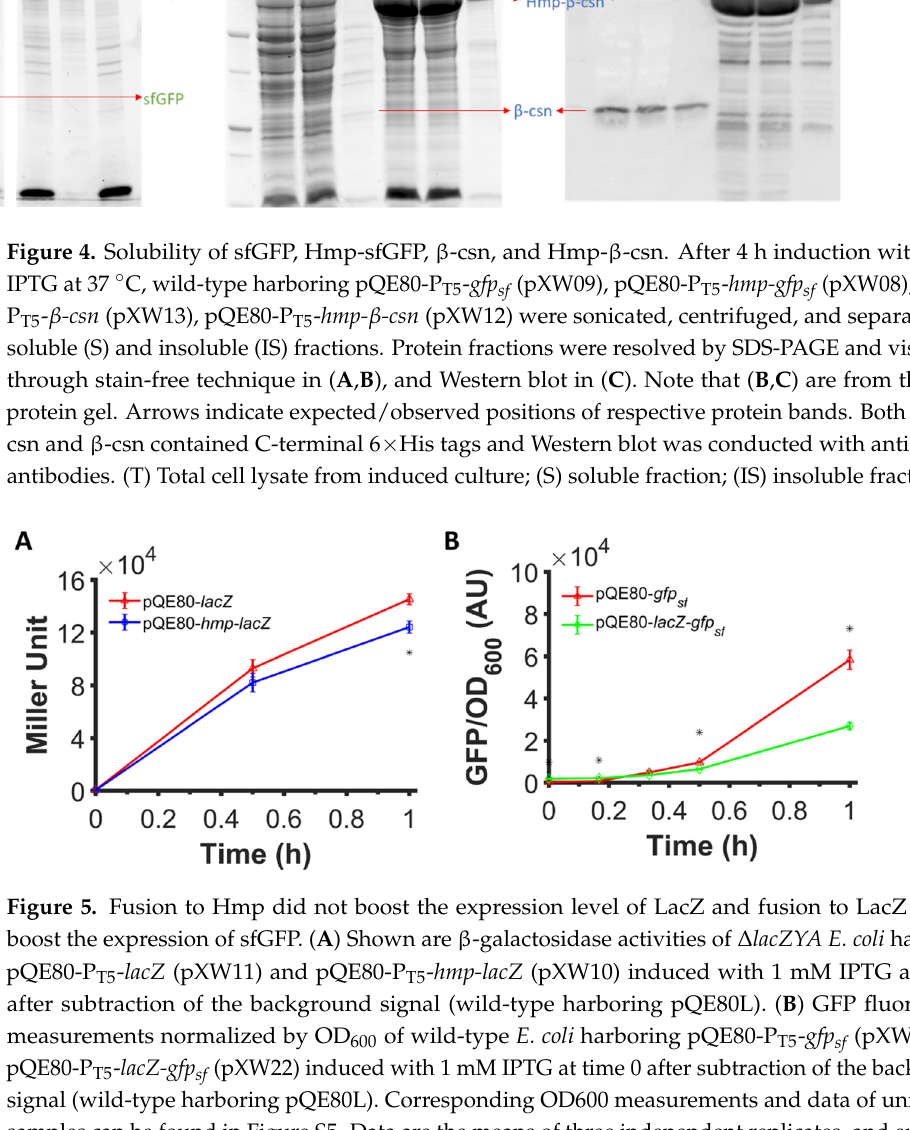
8 of 16 Figure 4. Solubility of sfGFP, Hmp-sfGFP, β -csn, and Hmp- β -csn. After 4 h induction with 1 mM IPTG at 37 °C, wild-type